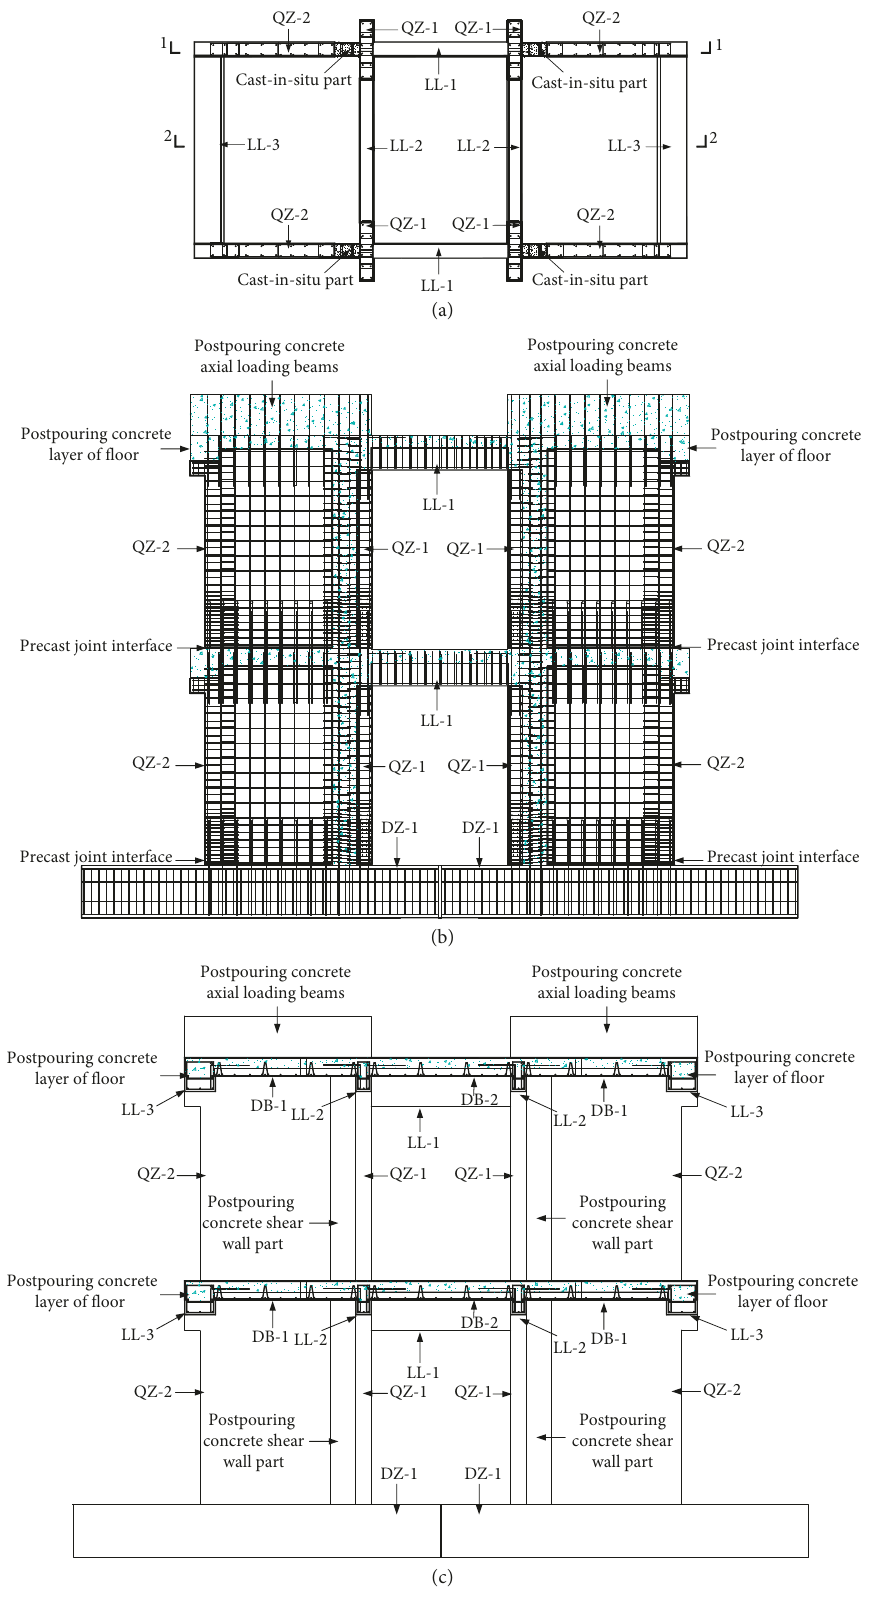
Figure 5: The assemble details of the NPGCS spatial model. (a) Components of the NPGCS spatial model in plan, (b) 1-1 sectional view of the NPGCS spatial model, and (c) 2-2 sectional view of the NPGCS spatial